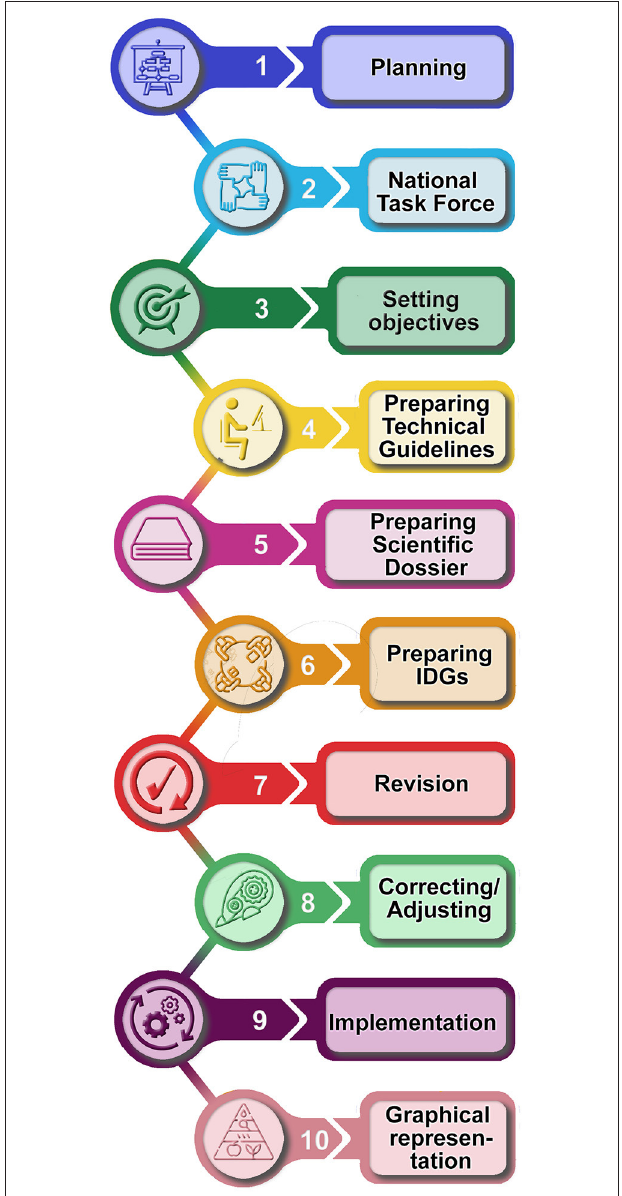
FIGURE 2 | Steps of preparing the